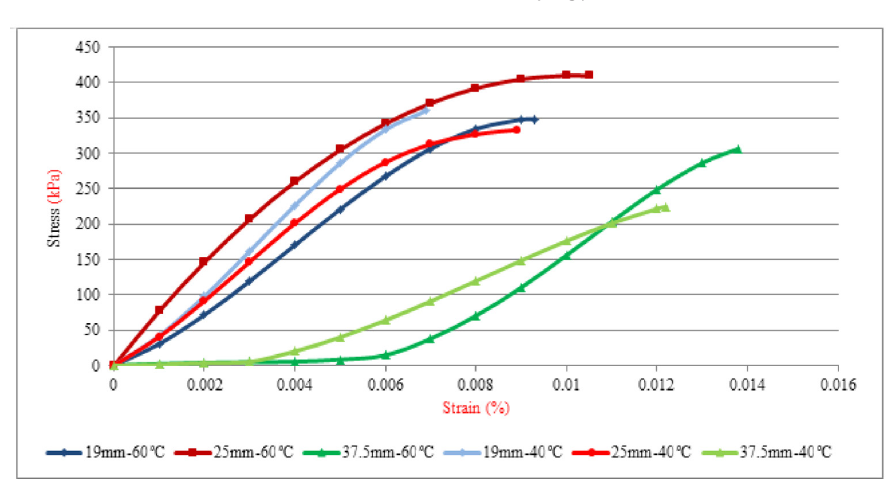
Fig. 1. Stress-strain curves for optimum samples at 40 °C and 60 °C